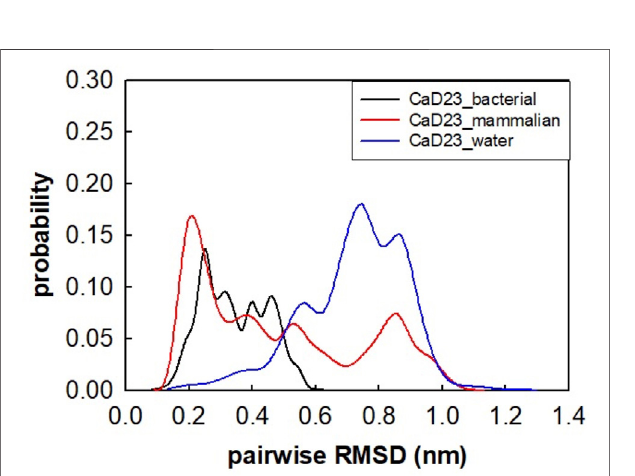
FIGURE 9 | Secondary structures of CaD23 in water and in 30% tri fl uoroethanol (TFE) determined by circular dichroism (CD) spectroscopy. CaD23 was shown to adopt a random coil conformation in water and an alpha-helical conformation in 30% TFE, corroborating the fi ndings of molecular dynamics